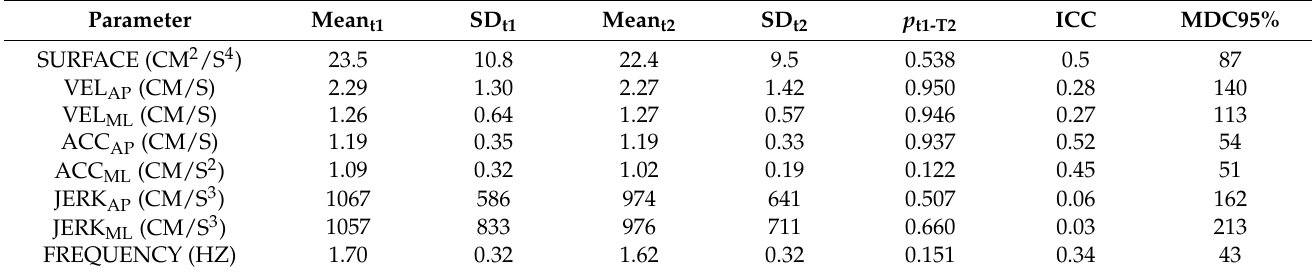
Table 2. Reliability and minimal detectable change: semi-tandem stance a hard surface ( n = 39). Parameter